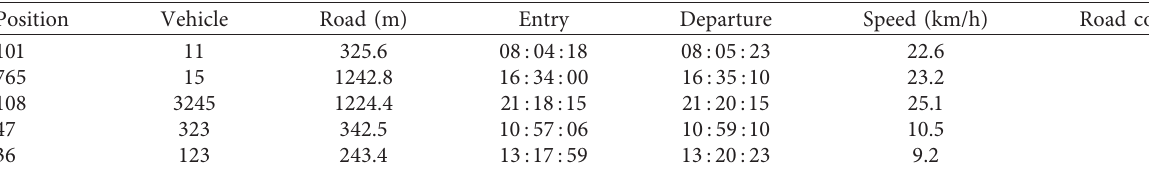
Table 3: Vehicle GPS road conditions.